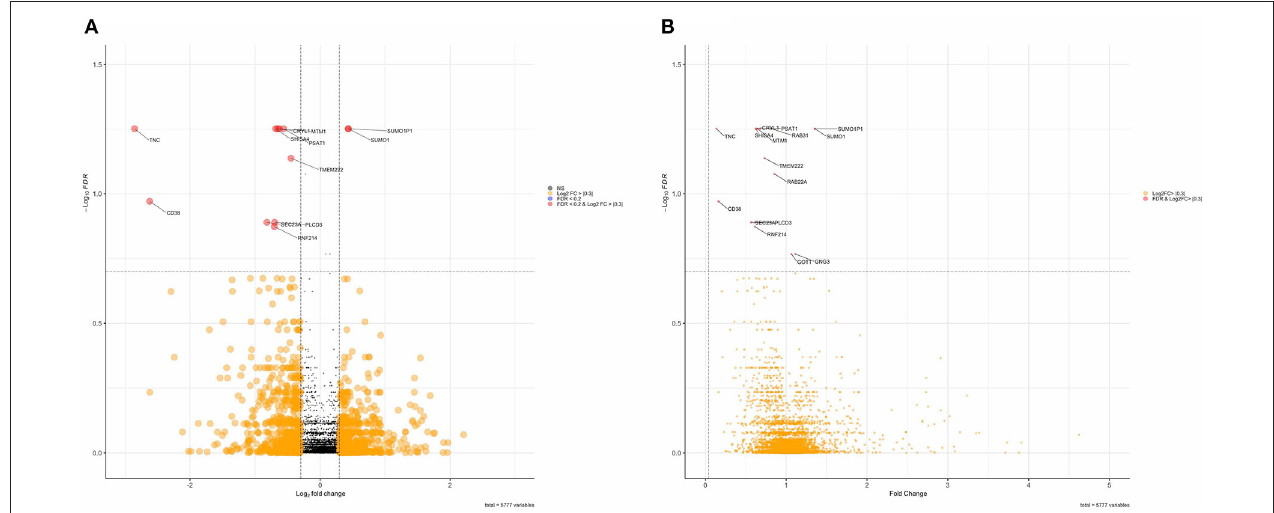
FIGURE 1 | (A) Volcano plot of Log2FC and false discovery rate (FDR) values of differentially abundant proteins. Red points are proteins with an FDR < 0.2. (B) Volcano plot of fold change values of differentially abundant proteins.